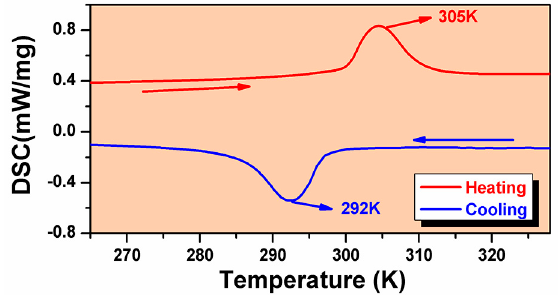
Figure 1. DSC curves of 1 .